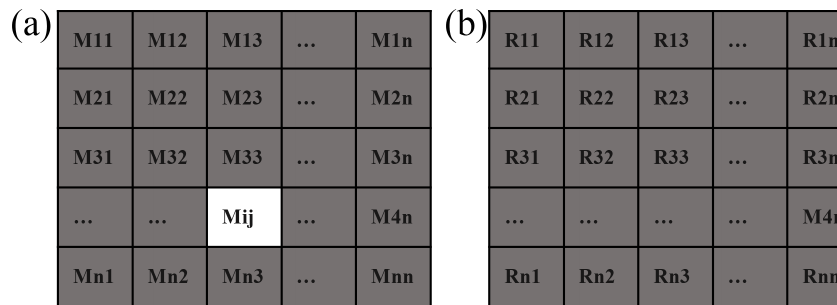
Figure 10. MODIS and microwave SST data corresponding to a n × n grid.